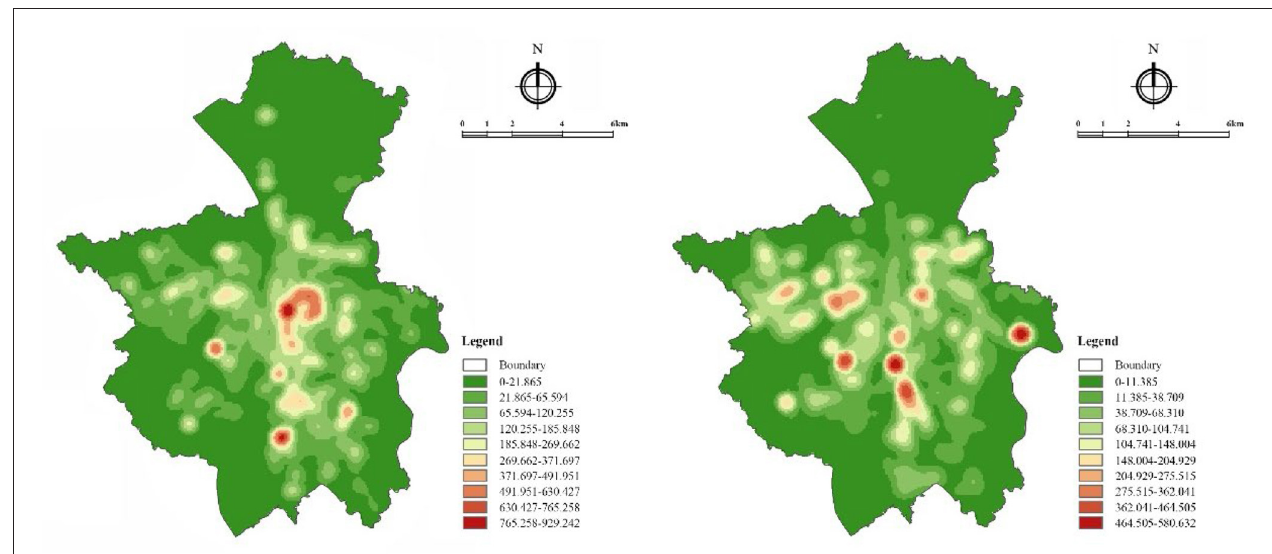
FIGURE 2 | Trajectory density distribution of walking (left) and running (right) activity.